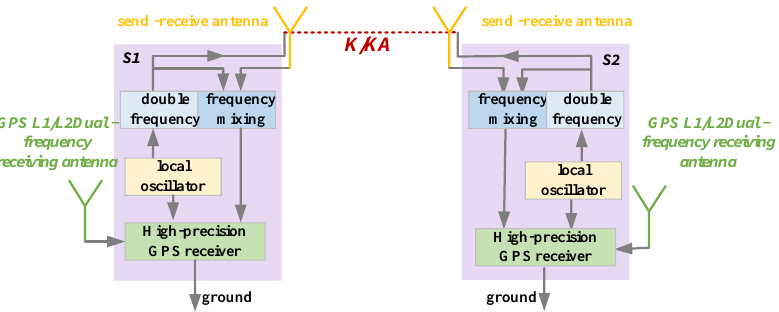
Figure 22. Structure diagram of the GRACE satellite KBR ranging system.